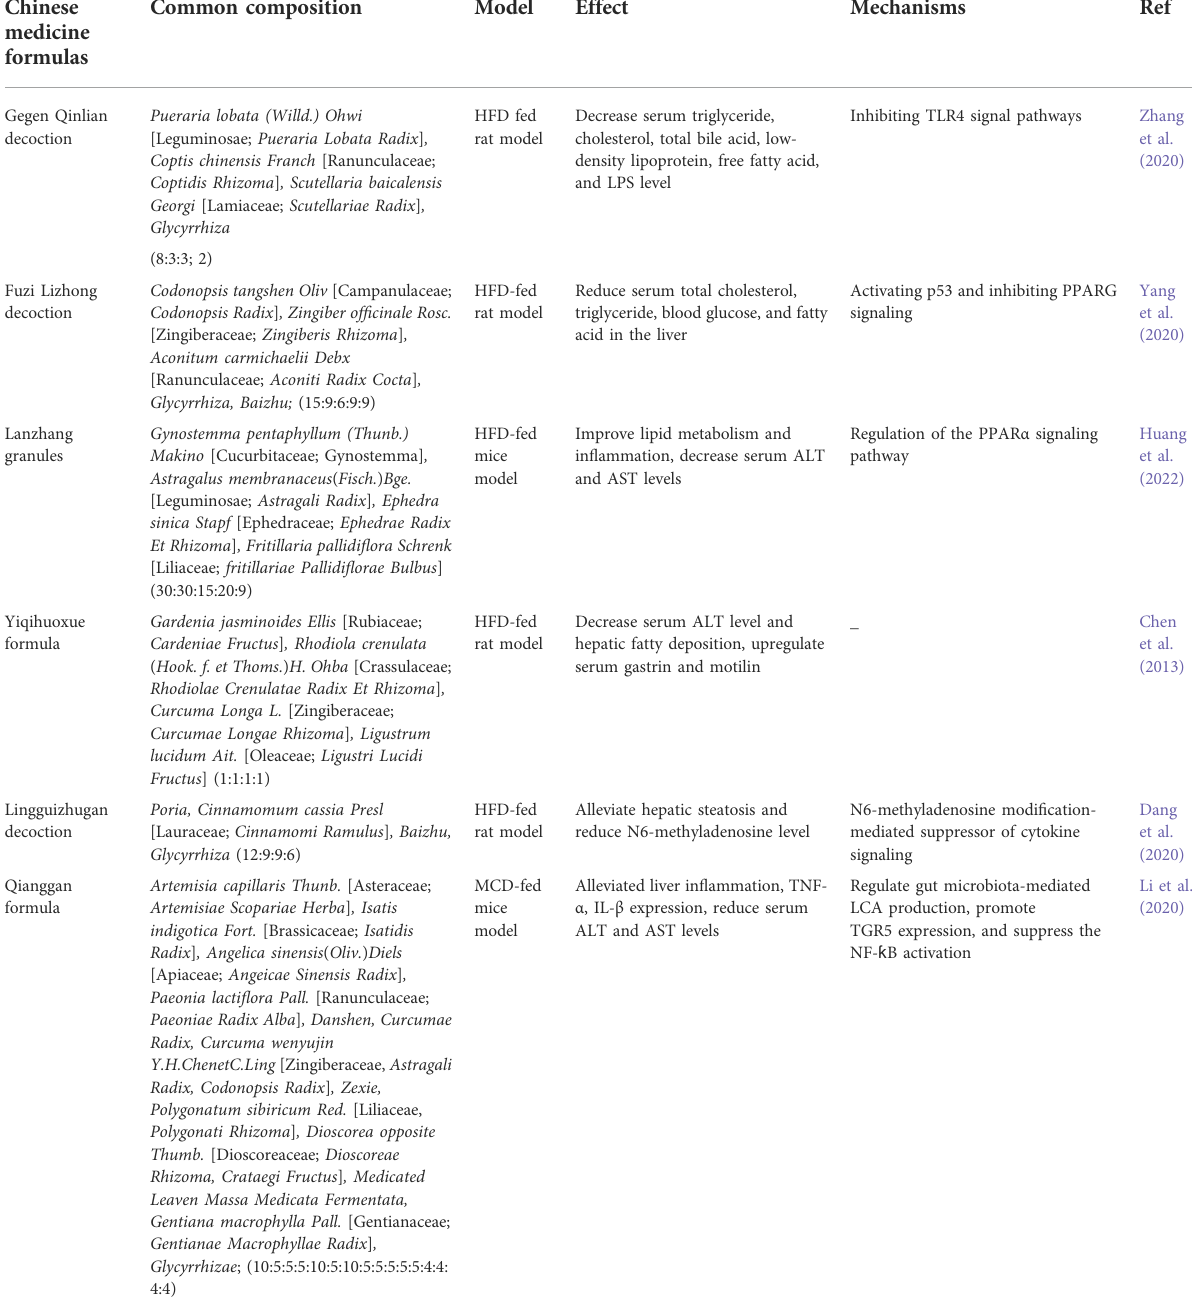
TABLE 1 Therapeutic effects of traditional Chinese medicine formulas on FLD. Chinese